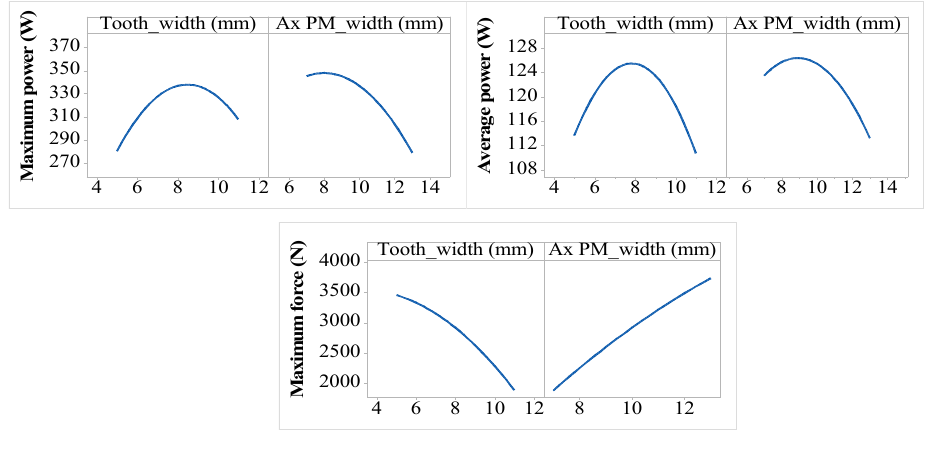
Figure 9. Main effect plot. Figure 9. Main e ff ect plot. Table 4. Factors and machine’s